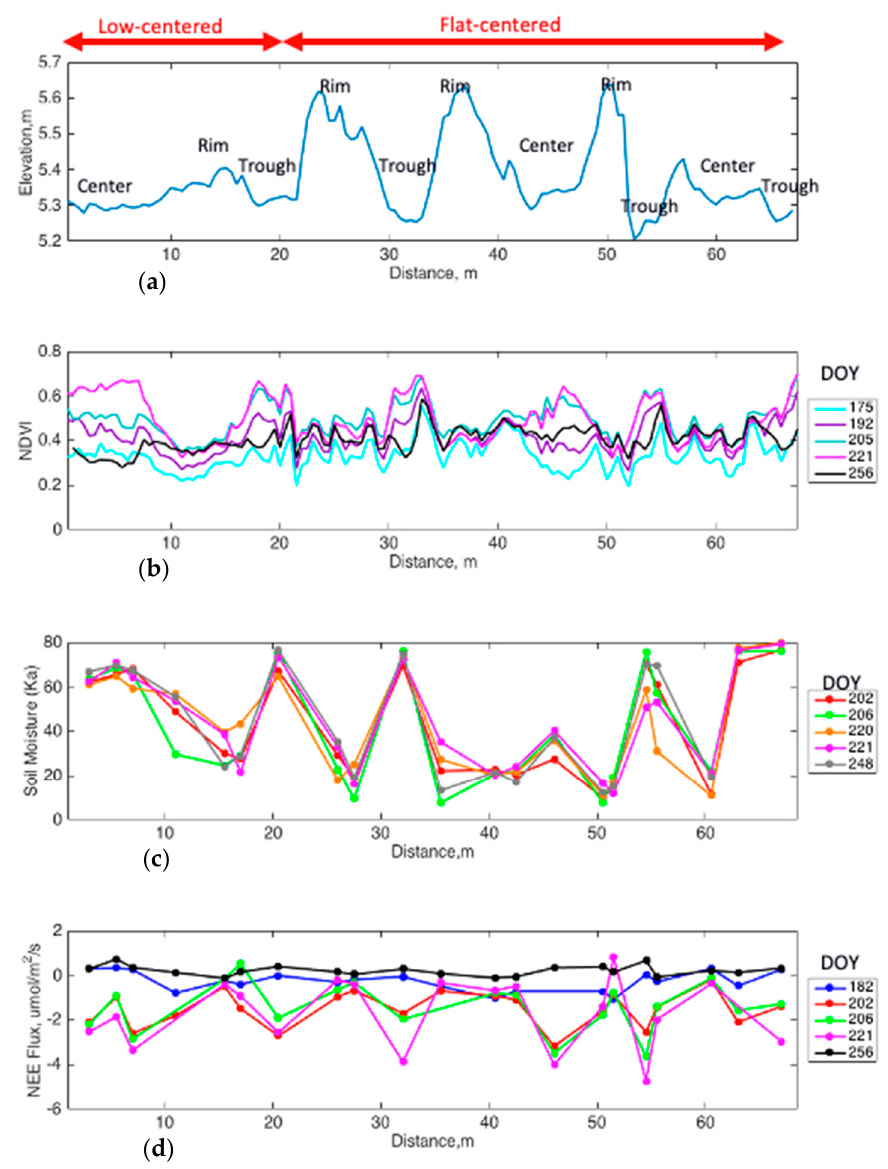
Figure 5. Spatiotemporal variability of observed properties along the tram transect: ( a ) LiDAR-based elevation with the polygon type-feature definition, ( b ) NDVI on the different day of year (DOY), ( c ) soil moisture (as dielectric permittivity K a ) and ( d ) NEE. In ( b ), the NDVI data are shown on selected DOYs. All the measurement dates are shown for soil moisture in ( c ) and for NEE in ( d ).